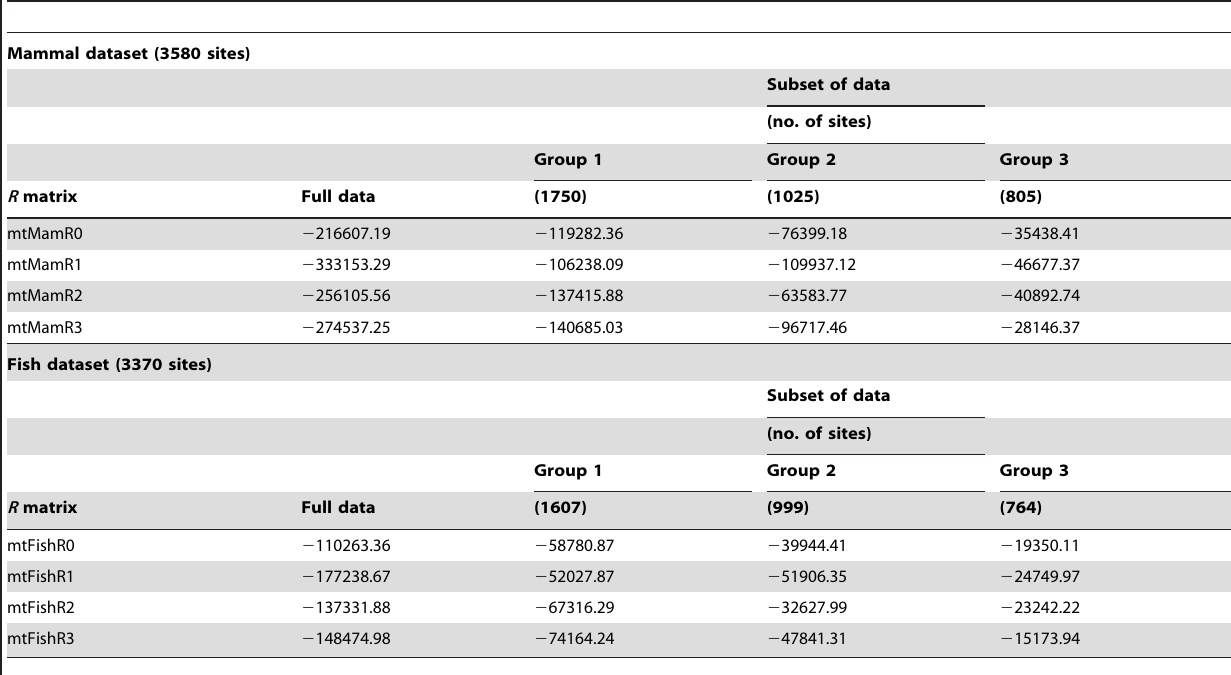
Table 3. Likelihood of full dataset and three partitions based on a rate matrix estimated from the complete data (R0) and three partition-specific rate matrices (R1, R2 and